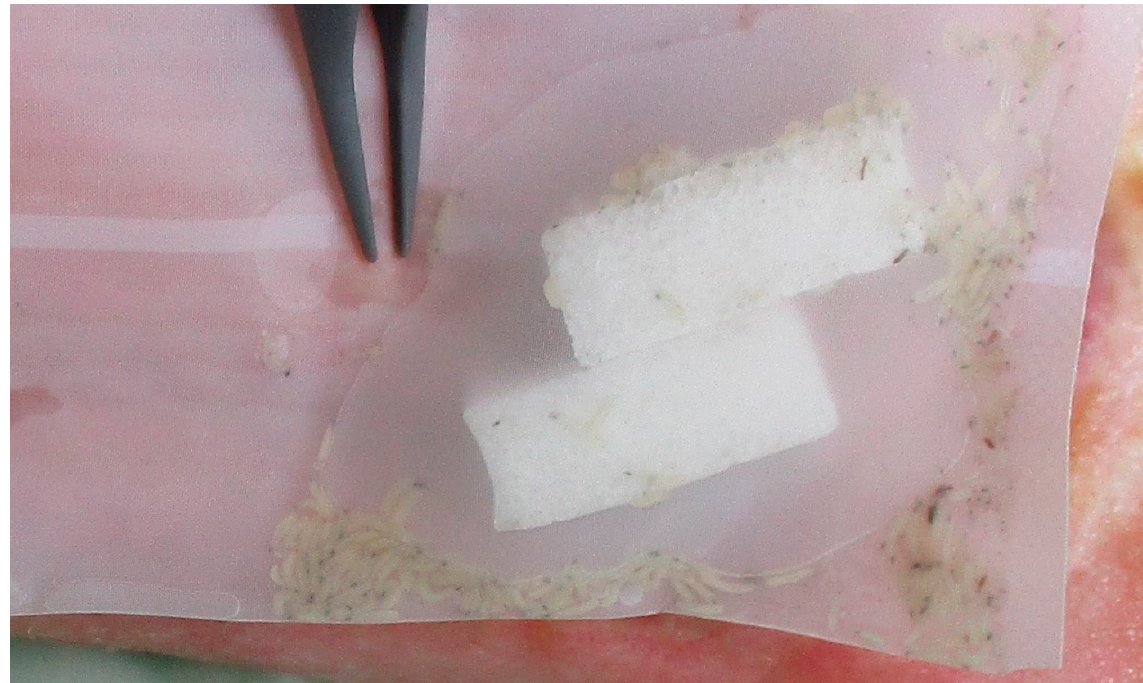
Figure 2. Lucilia sericata larvae enclosed in a biobag and applied to the wound.